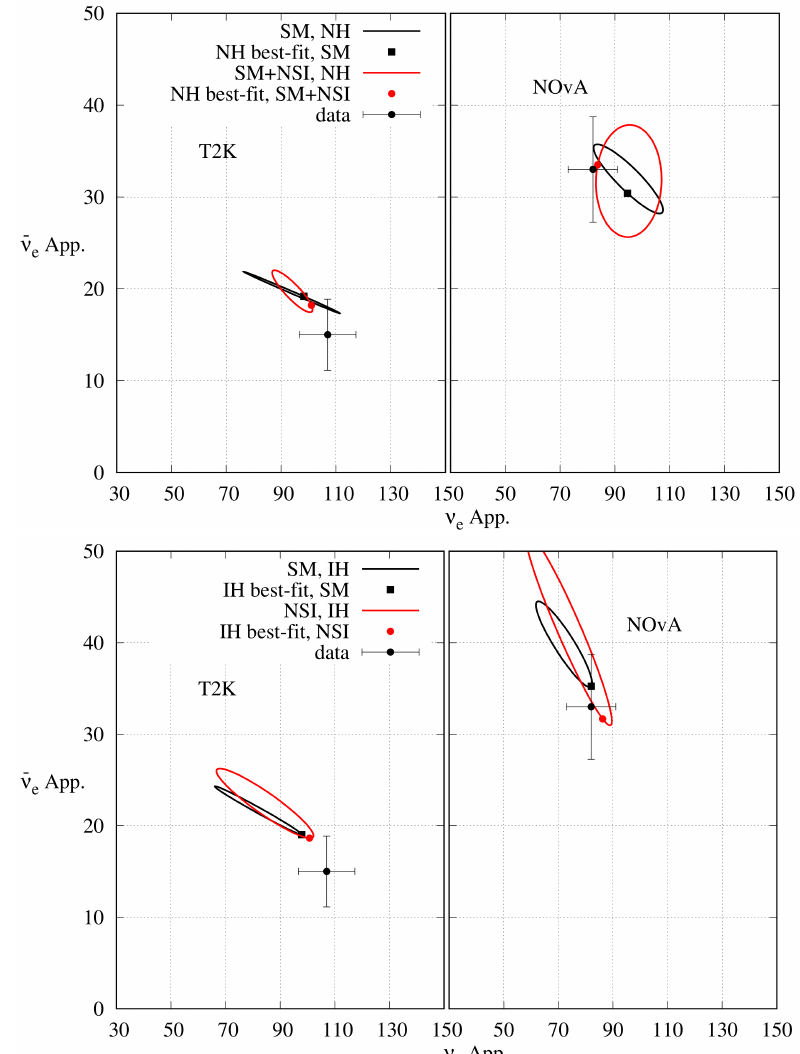
Figure 16. Bi-event plot for T2K (NO ν A) in left ( right ) panel . The upper ( lower ) panel is for NH (IH). To generate the ellipses, δ CP has been varied in the range [ − 180 ◦ :180 ◦ ] while keeping all other parameters fixed. Among the NSI parameters, only the effect of (cid:101) e τ has been considered. The black (red) ellipses represent the SM (NSI) case with the best-fit points indicated by black square (red circle). The ellipses and the best-fit points have been determined by fitting the combined data from NO ν A and T2K. The black circle with error bars represent the experimental